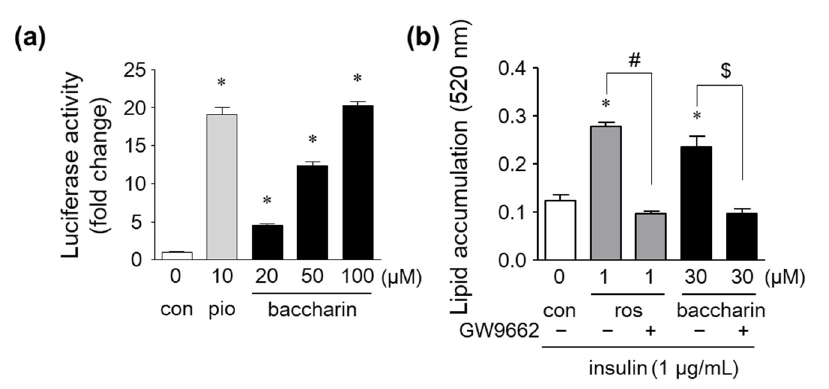
Figure 6. Effects of baccharin on PPAR γ -dependent transcriptional activity and PPAR γ antagonism on baccharin-induced lipid accumulation. ( a ) CV-1 cells were transfected with reporter genes and cultured with pioglitazone or baccharin for 48 h. PPAR γ -dependent transcriptional activity was measured by a dual-luciferase reporter assay. ( b ) 3T3-L1 cells were cultured in the presence of rosiglitazone (1 µ M) or baccharin (30 µ M) with or without GW9662 (10 µ M) and then stained with Oil Red O. The amount of accumulated lipid droplets stained with Oil Red O was determined. Values are expressed as means ± SEM ( n = 3). * p < 0.05 compared with the control; # p < 0.05 versus 1 µ M rosiglitazone-treated cells; $ p < 0.05 versus 30 µ M baccharin-treated cells. pio, pioglitazone. ros, rosiglitazone.